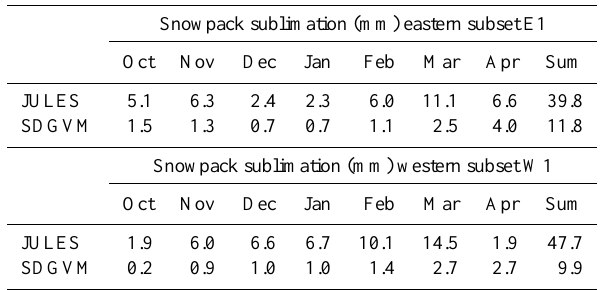
Table 2. Simulations of monthly snowpack sublimation (October to April) and total sublimation for the JULES and SDGVM models for the eastern and western Eurasian subsets shown in Fig.